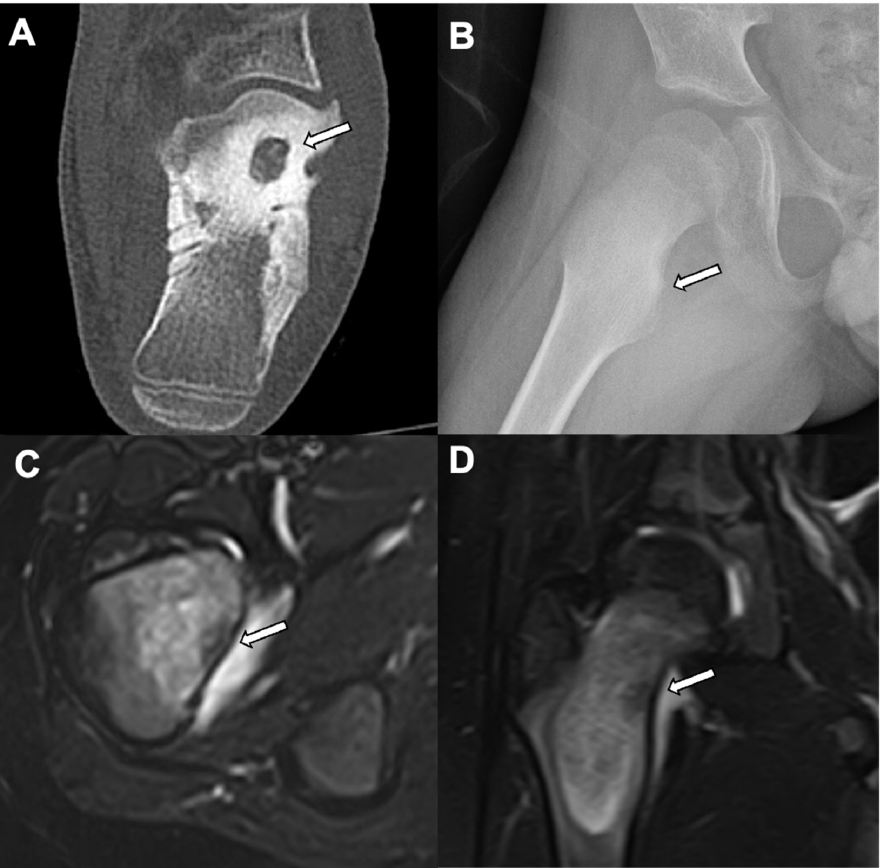
Figure 4. Osteoid osteoma: A left foot CT of the bone window (axial view) shows a central well defined lytic lesion along the anterosuperior calcaneum with diffuse surrounding sclerosis (white arrow) in a 10-year-old male ( A ). Another 12-year-old patient with nighttime right hip pain showed focal ill-defined sclerosis along the right medial femoral neck cortex (white arrow) ( B ). This patient’s MRI shows focal T2 hypointensity in the right medial femoral neck cortex with surrounding bone marrow edema (white arrows) of the femoral neck in T2 fat saturation (axial ( C ) and coronal ( D ) views).